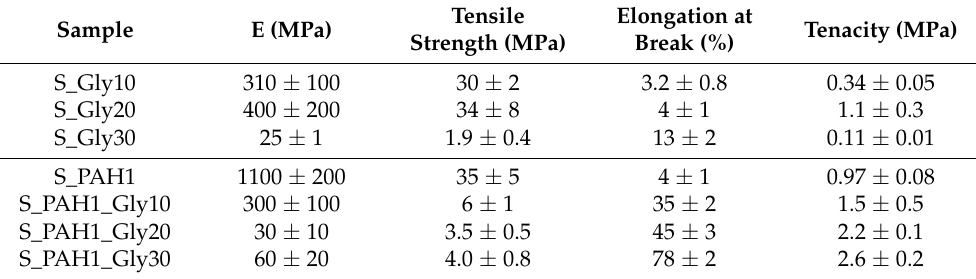
Figure 6. Stress-strain curves of S_GlyX films ( A ), S_PAH1_GlyX films ( B ) and comparison of stress strain curves with or without PAH at 10% ( C ) and 30% ( D ) Gly content. Table 2. Elastic modulus (E), Tensile Strength (TS), Elongation at break (EB) and Tenacity (T) of S_GlyX and S_PAH1_GlyX films.